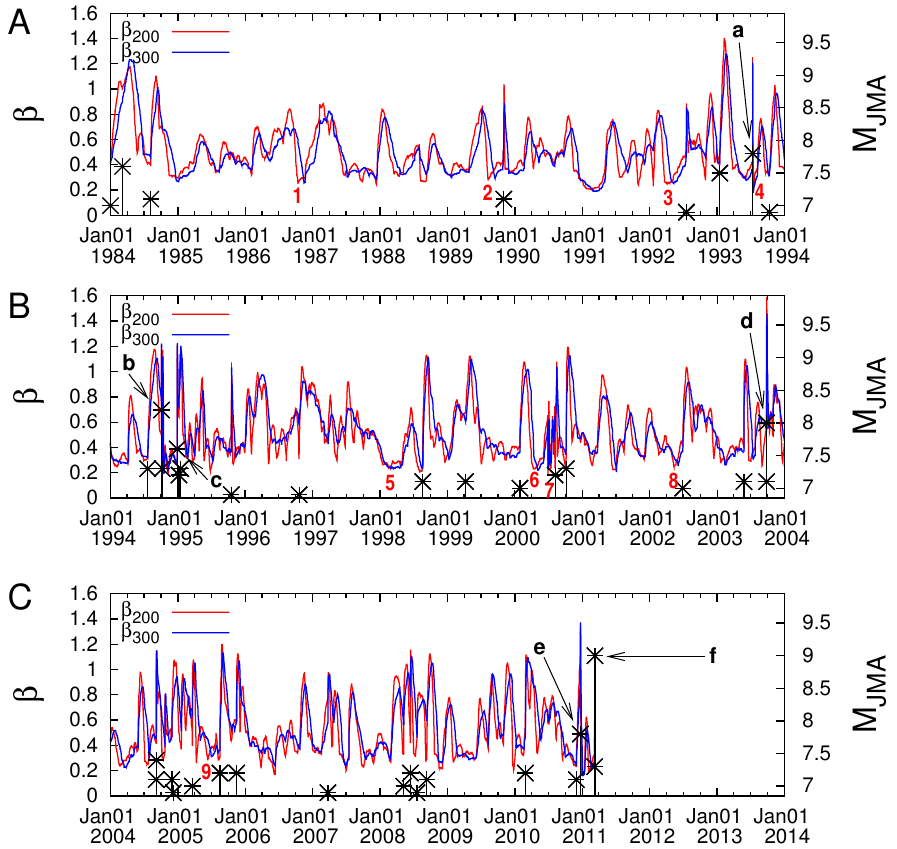
Figure 5. Variability β versus the conventional time given in three consecutive 10-year periods in ( A – C ), respectively. Every tick corresponds to 3 months in the horizontal scale. Taken from Ref. [36]. No data are plotted in ( C ) after M 9 Tohoku EQ. The EQ mangitudes M JMA are shown by black asterisks read in the right